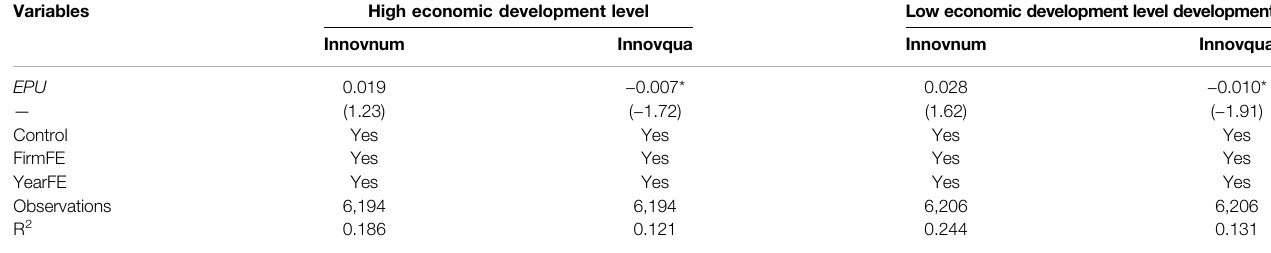
TABLE 9 | Heterogeneity of the economic development level. Variables